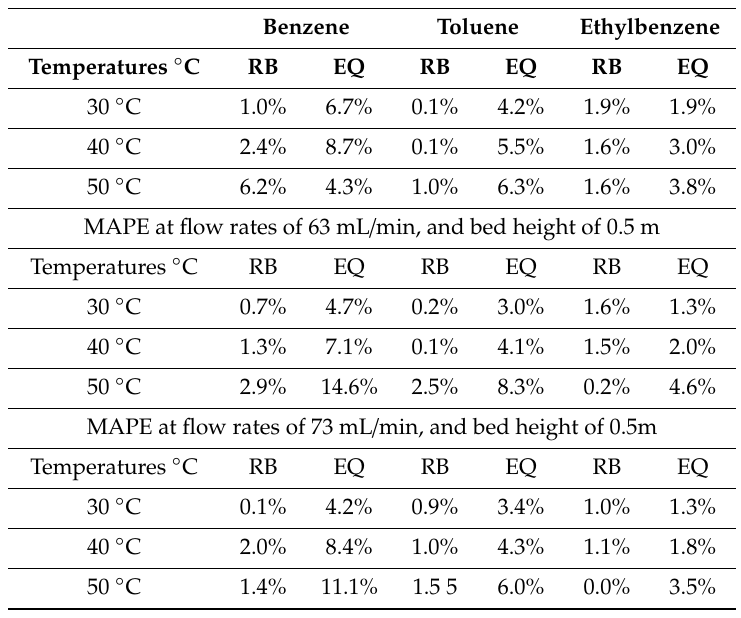
Table 7. MAPE between the values calculated using the models (RB and EQ) and those obtained from empirical measurement at a bed height of 0.8